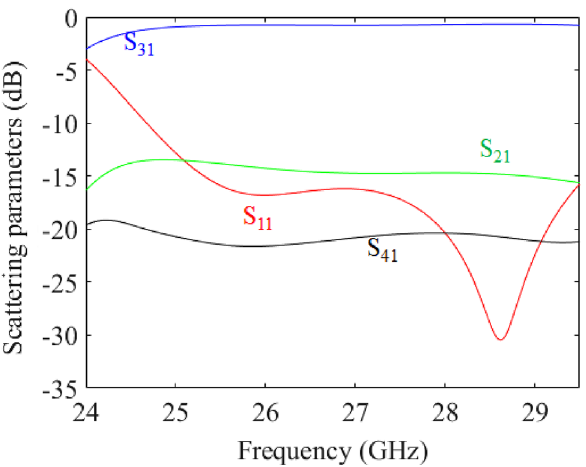
Figure 8. Simulated scattering parameters for the structure in Fig. 6b with a realistic model for the PIN-diodes, accounting for the main parasitic